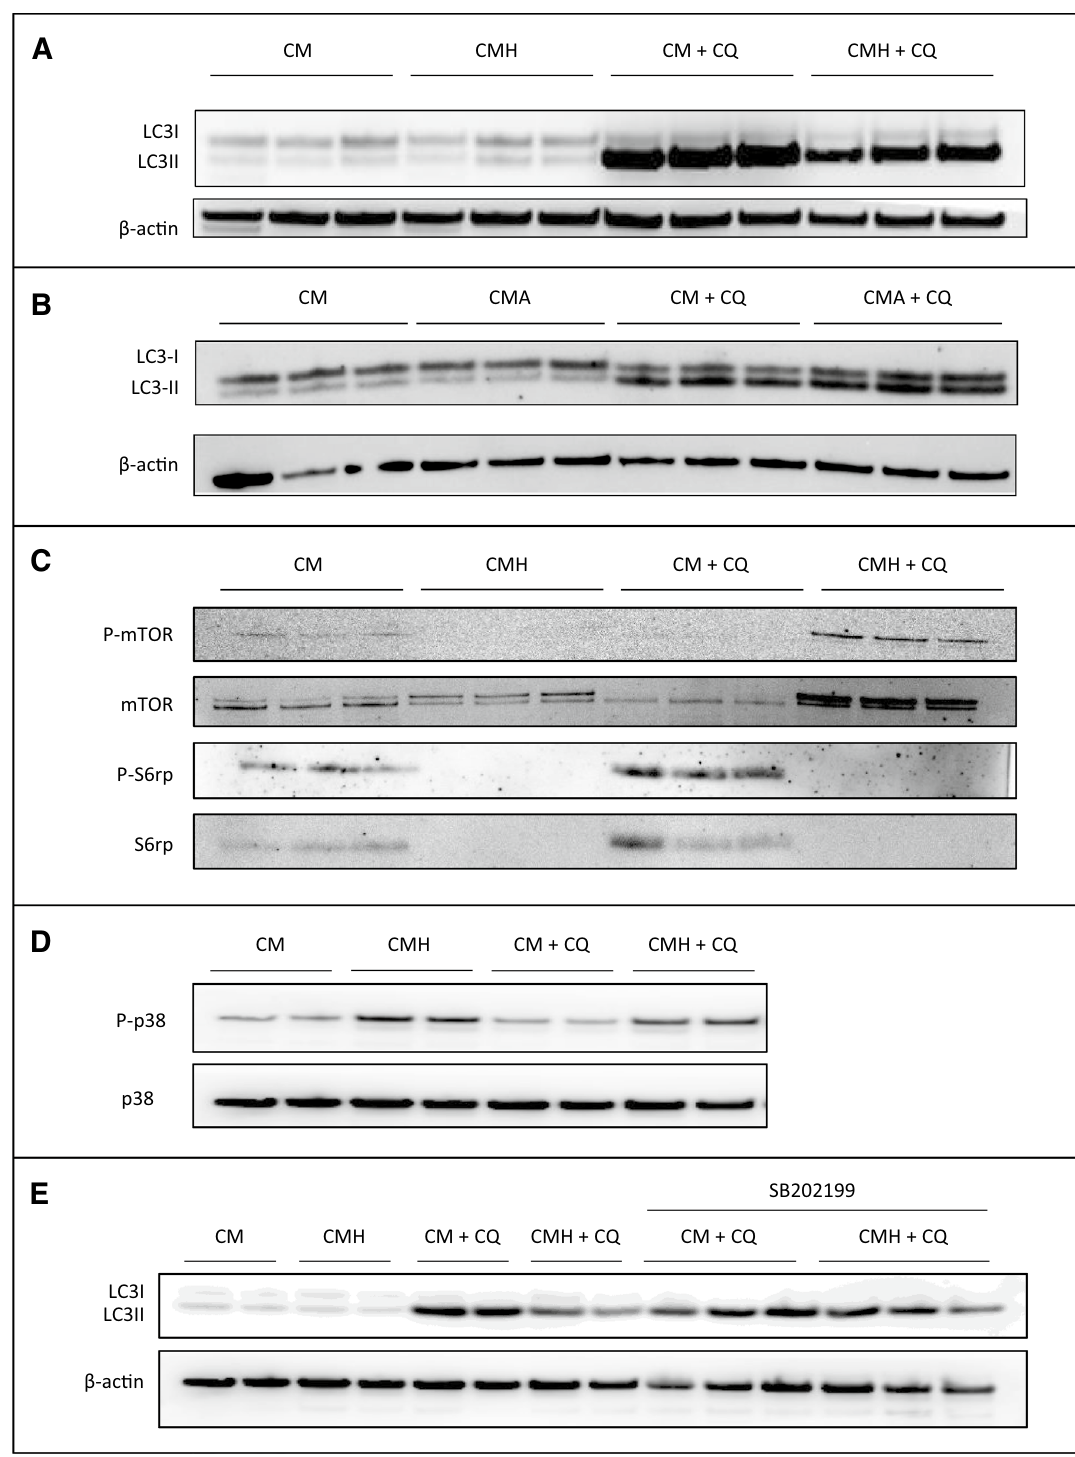
Figure 7. Tumor cells inhibit macrophage autophagy. ( A ) Representative western blot analysis of LC3 and β-actin in peritoneal macrophages exposed to the conditioned medium of Hepa1-6 cells (CMH) or to control medium (CM) in the presence or absence of 10 µM chloroquine (CQ). ( B ) Representative western blot analysis of LC3 and β-actin in peritoneal macrophages exposed to the conditioned medium of AML-12 cells (CMA) or to control medium (CM) in the presence or absence of 10 µM chloroquine (CQ). ( C ) Representative western blot analysis of P-mTOR, mTOR, P-S6rp and S6rp in peritoneal macrophages exposed to the conditioned medium of Hepa1-6 cells (CMH) or to control medium (CM) in the presence or absence of 10 µM chloroquine (CQ). ( D ) Representative western blot analysis of P-p38 and p38 in peritoneal macrophages exposed to the conditioned medium of Hepa1-6 cells (CMH) or to control medium (CM) in the presence or absence of 10 µM chloroquine (CQ). ( E ) Representative western blot analysis of LC3 and β-actin in peritoneal macrophages exposed to the conditioned medium of Hepa1-6 cells (CMH) or to control medium (CM) in the presence or absence of 10 µM chloroquine (CQ) and of 10 µM